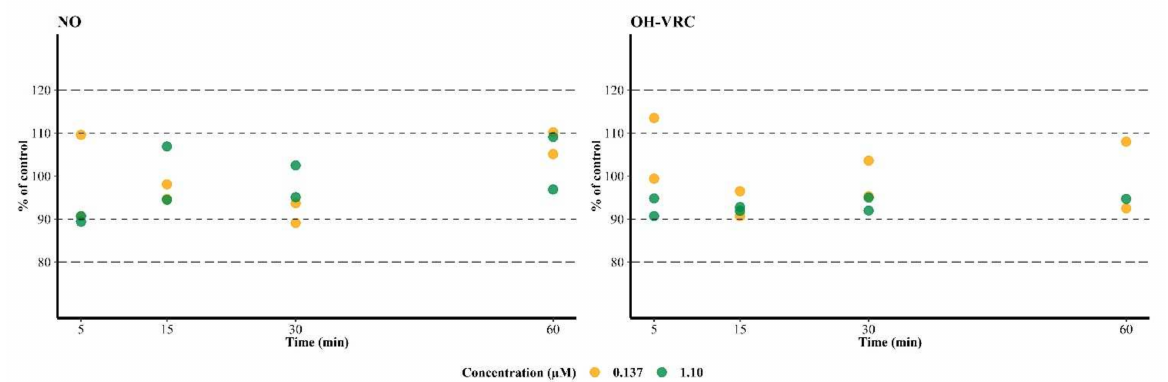
Figure 3. Stability of voriconazole N -oxide (NO) and hydroxyvoriconazole (OH–VRC) in human liver microsomes over time at two concentrations ( n = 1–2 each), presented as the percentage of a control incubation ( n = 1). Dashed lines— ± 10% and ± 20% deviation from the